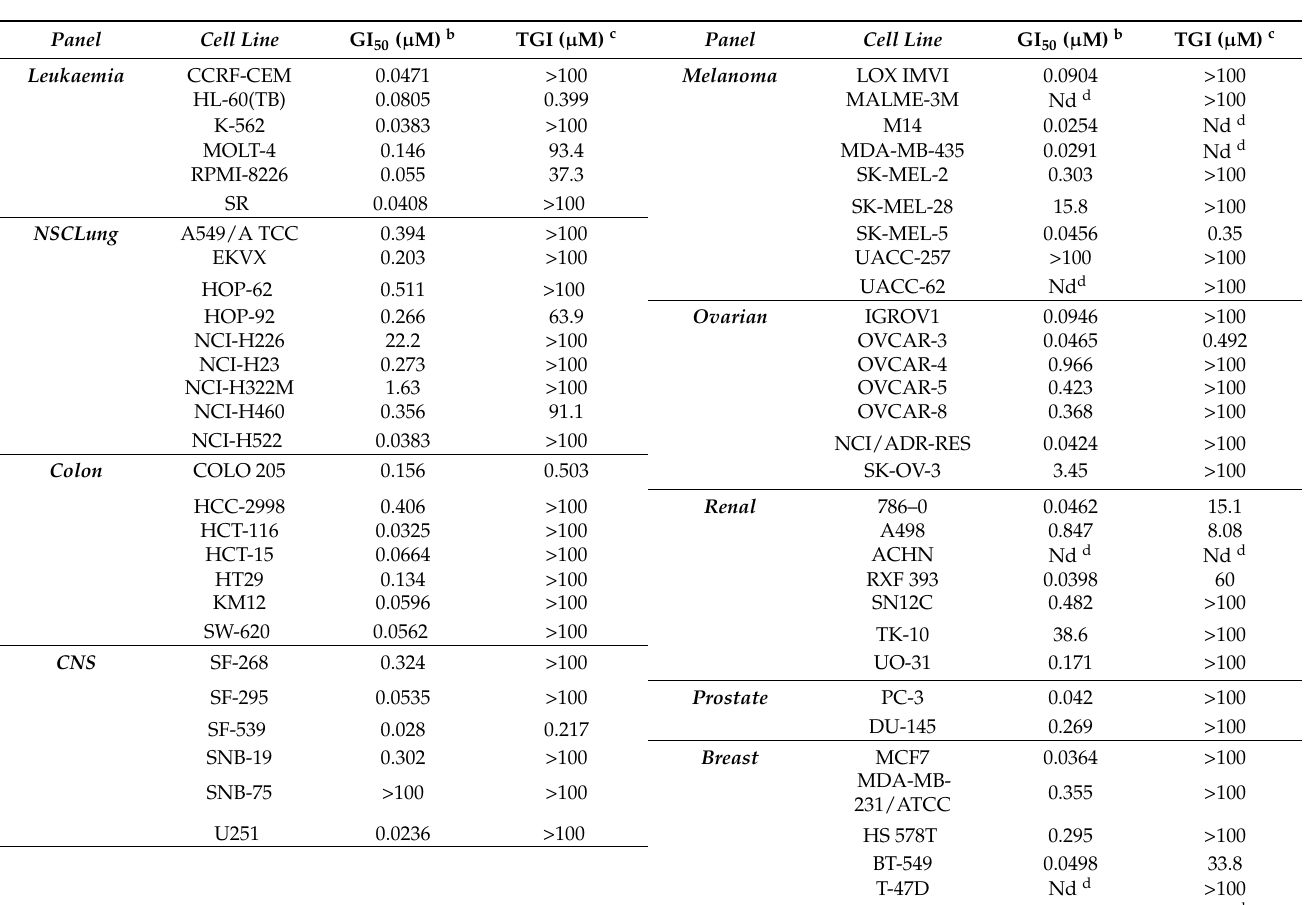
Table 5. Antiproliferative activity of compound 33 in NCI 60 cell line screen a,b,c,d